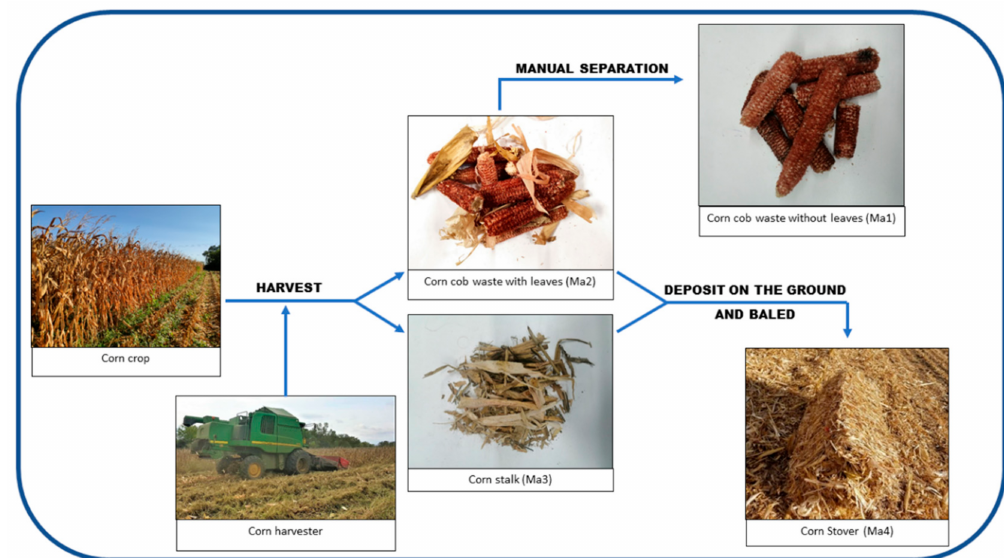
Figure 1. Scheme of harvest system and residues from corn